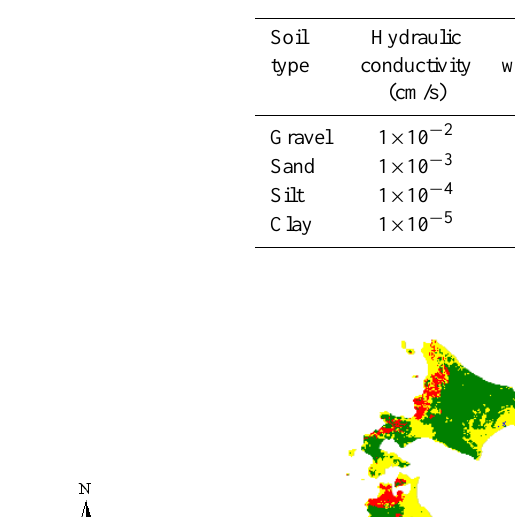
Table 1. Properties of four soil types used for infiltration analysis.